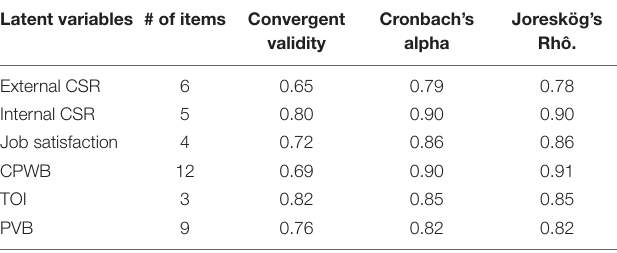
Table 5 . The significance level is given in brackets whereas the